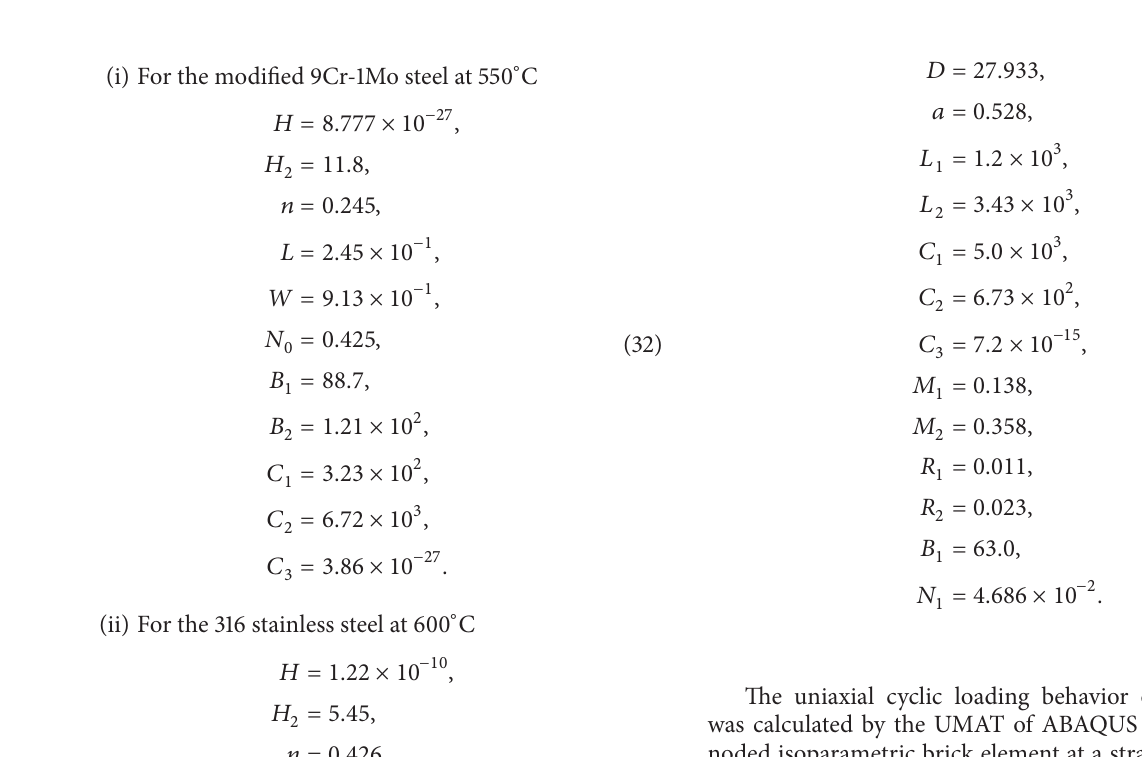
Figure 3: Analysis flow chart of a cyclic hardening